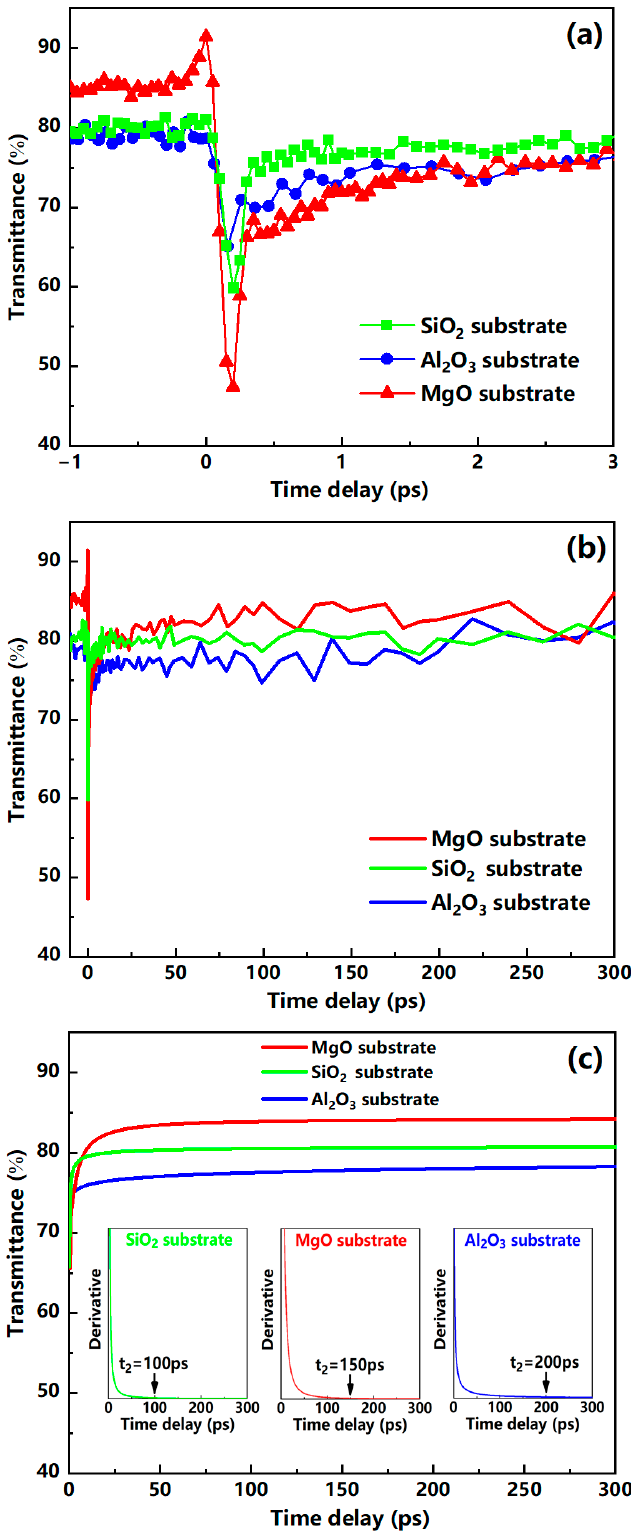
Figure 8. Transient transmittance changes in V 2 O 5 films on three substrates (Al 2 O 3 /MgO/SiO 2 ) induced by laser pulses with an energy density of 0.0622 mJ/cm 2 . ( a ) Partial data showing the initial response and recovery of V 2 O 5 films; ( b ) full-track data. ( c ) Fitting and deriving (three insets) to the recovery process data to obtain the recovery time t 2.